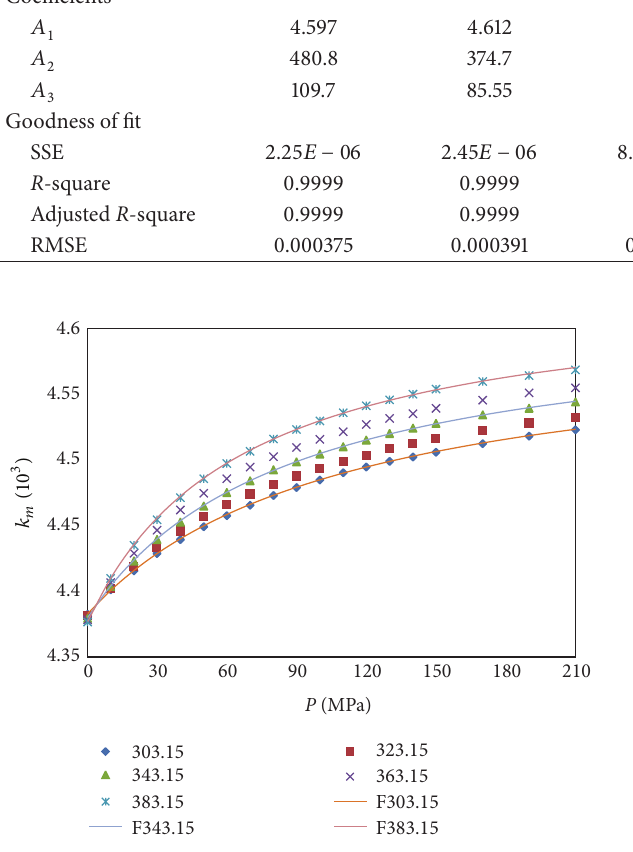
Figure 2: Molecular compressibility of ethyl caprate (EeC10:0) as a function of pressure along various isothermal (the lines are fitting results; the dots are calculated